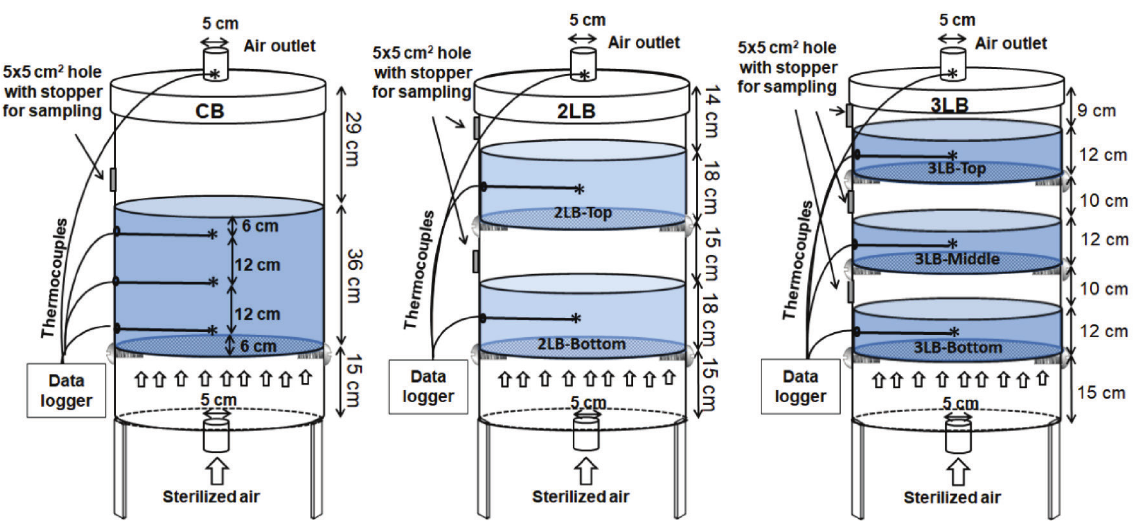
Fig. 1 – Schematics of packed-bed bioreactors used in this study (a) control packed-bed bioreactor, cB; (b) Two-layered packed- bed bioreactor, 2lB; (c) Three-layered packed-bed bioreactor, 3lB; The * symbols represent the positions for temperature measure -